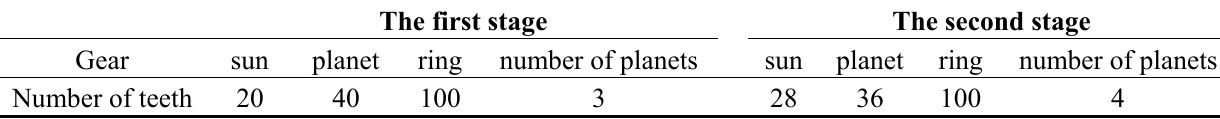
Table 1. Gear parameters in the two-stage planetary gearbox. The first